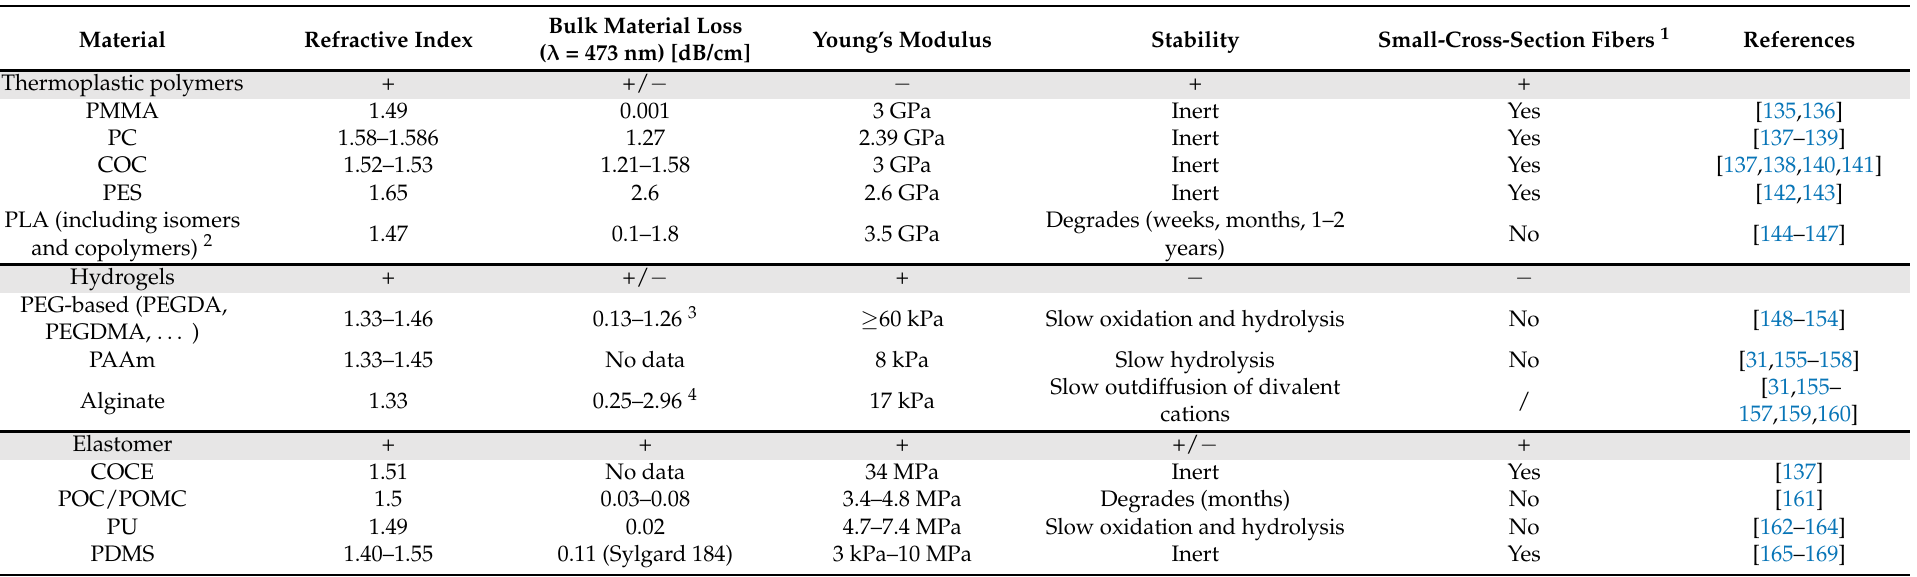
Table 2. Optical, mechanical and biological properties of biomaterials mentioned in Section